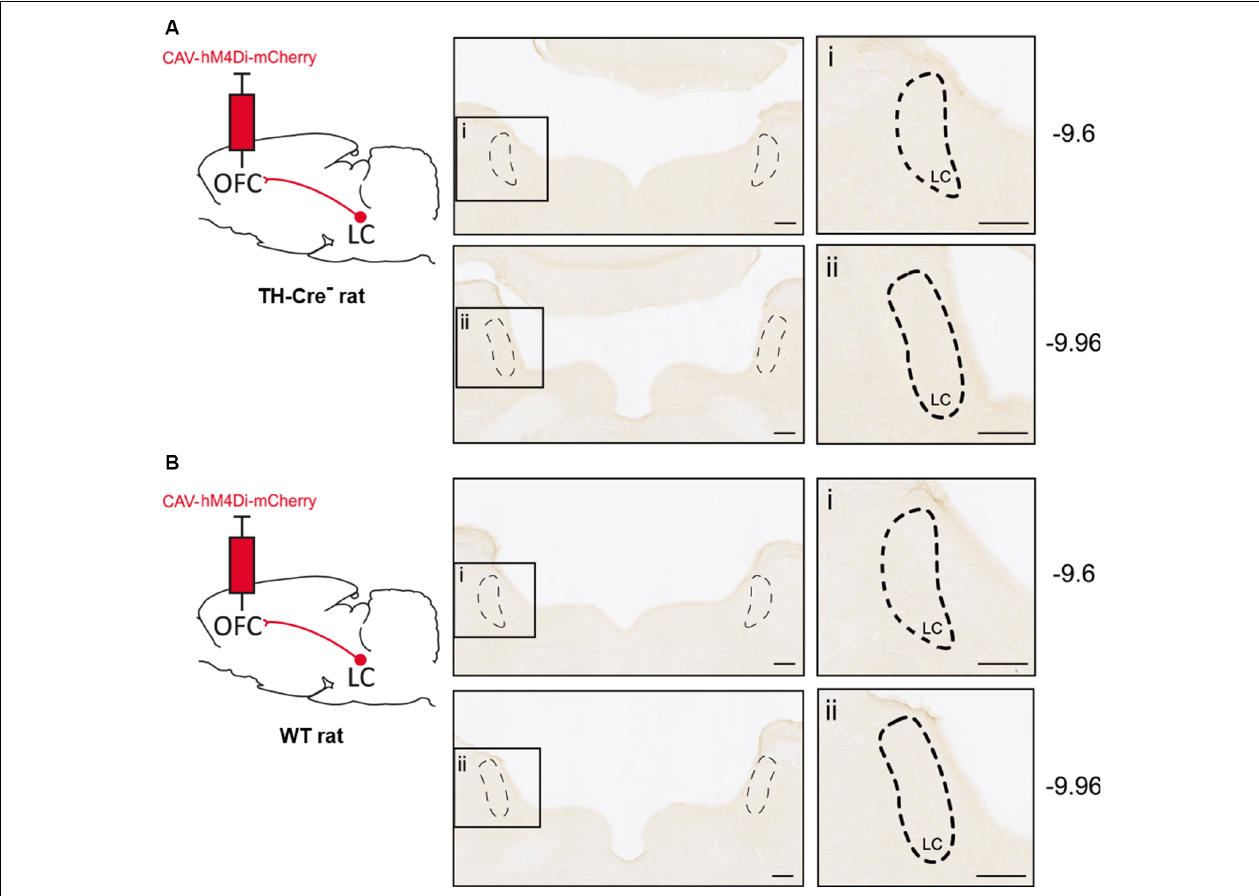
FIGURE 3 | Absence of CAV-hM4Di expression in animals lacking Cre-recombinase. (A) DAB immunostaining in LC after injection of CAV-hM4Di in the OFC of transgene-negative littermate TH-cre − at two AP coordinates (AP − 9.6 mm and AP − 9.96 mm). (B) DAB immunostaining in LC with the same injection in wild-type